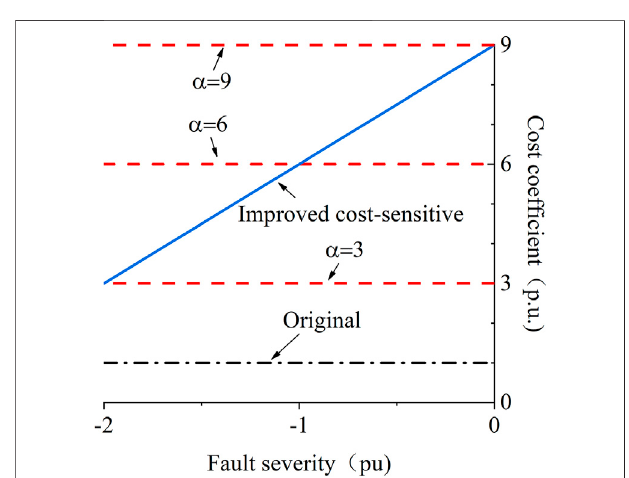
FIGURE 4 | Unstable sample cost-sensitive assignment method of different